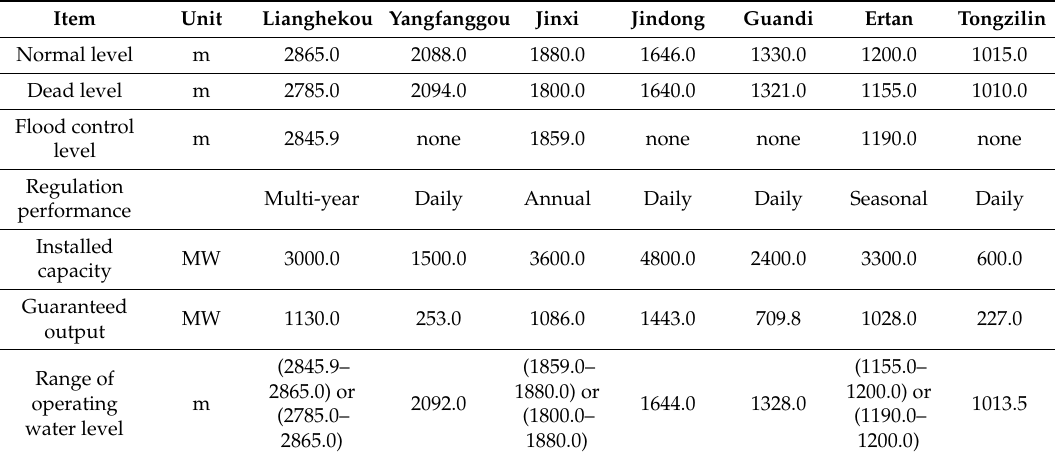
Table 1. The key parameters of the 7